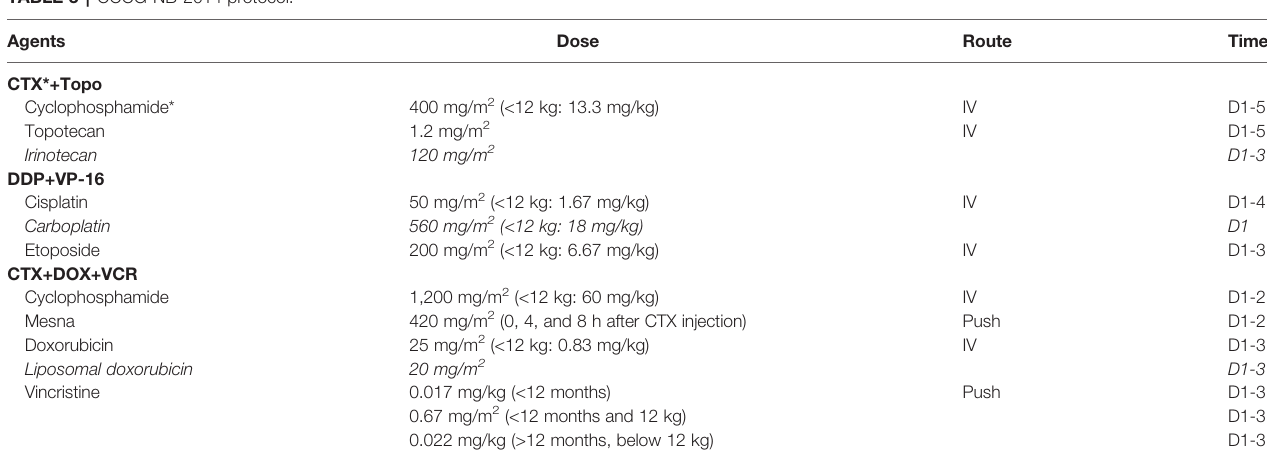
TABLE 3 | CCCG-NB-2014